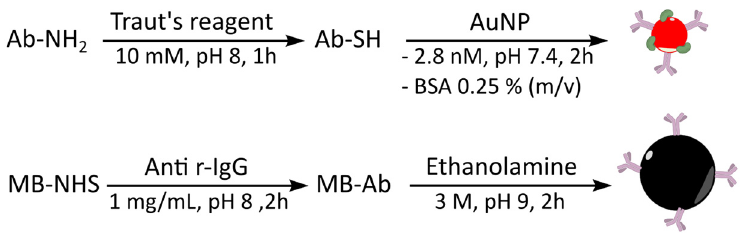
Figure 2. Conjugation of goat anti-rabbit IgG (Ab) to AuNP and NHS-activated magnetic beads (MB).